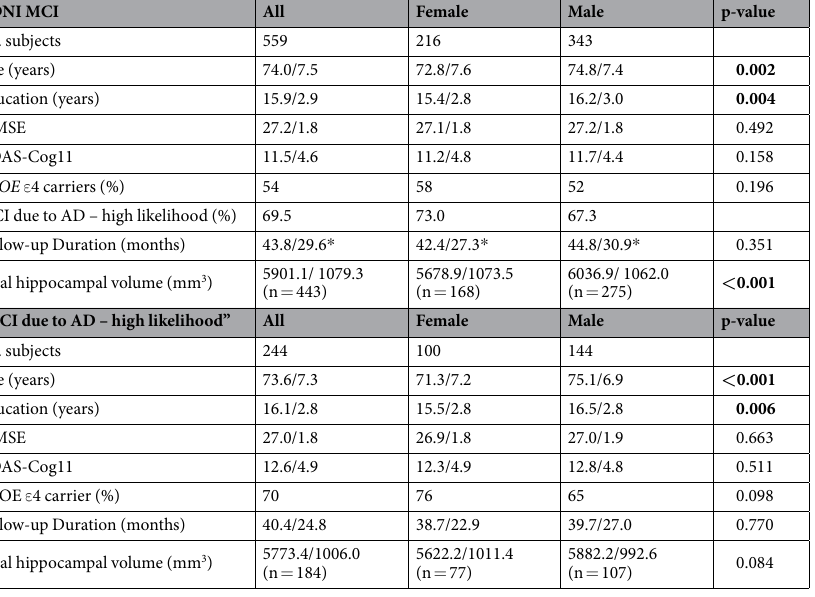
Table 1. Baseline Demographic and Clinical Characteristics by Sex of Subjects. ANOVA (Analysis of variance) assessed differences in age, education year, follow-up duration and ANCOVA (Analysis of covariance) assessed sex-differences in baseline MMSE and ADAS-Cog11 scores adjusting for age, years of education. Data are expressed as mean/standard deviation, as appropriate. Bold p -values are statistically significant. Abbreviations: AD (Alzheimer’s disease), MCI (mild cognitive impairment), ADAS-Cog11 (Alzheimer’s disease assessment scale- cognitive subscale), MMSE (mini- mental state examination), and APOE ε 4 (apolipoprotein ε 4 allele). Follow-up duration is calculated based on ADAS-Cog 11 measurement. CSF t-tau/A β 42 ratio cut-offs were used to classify subjects as having “high” likelihood of meeting criteria for “MCI due to AD”. See text for